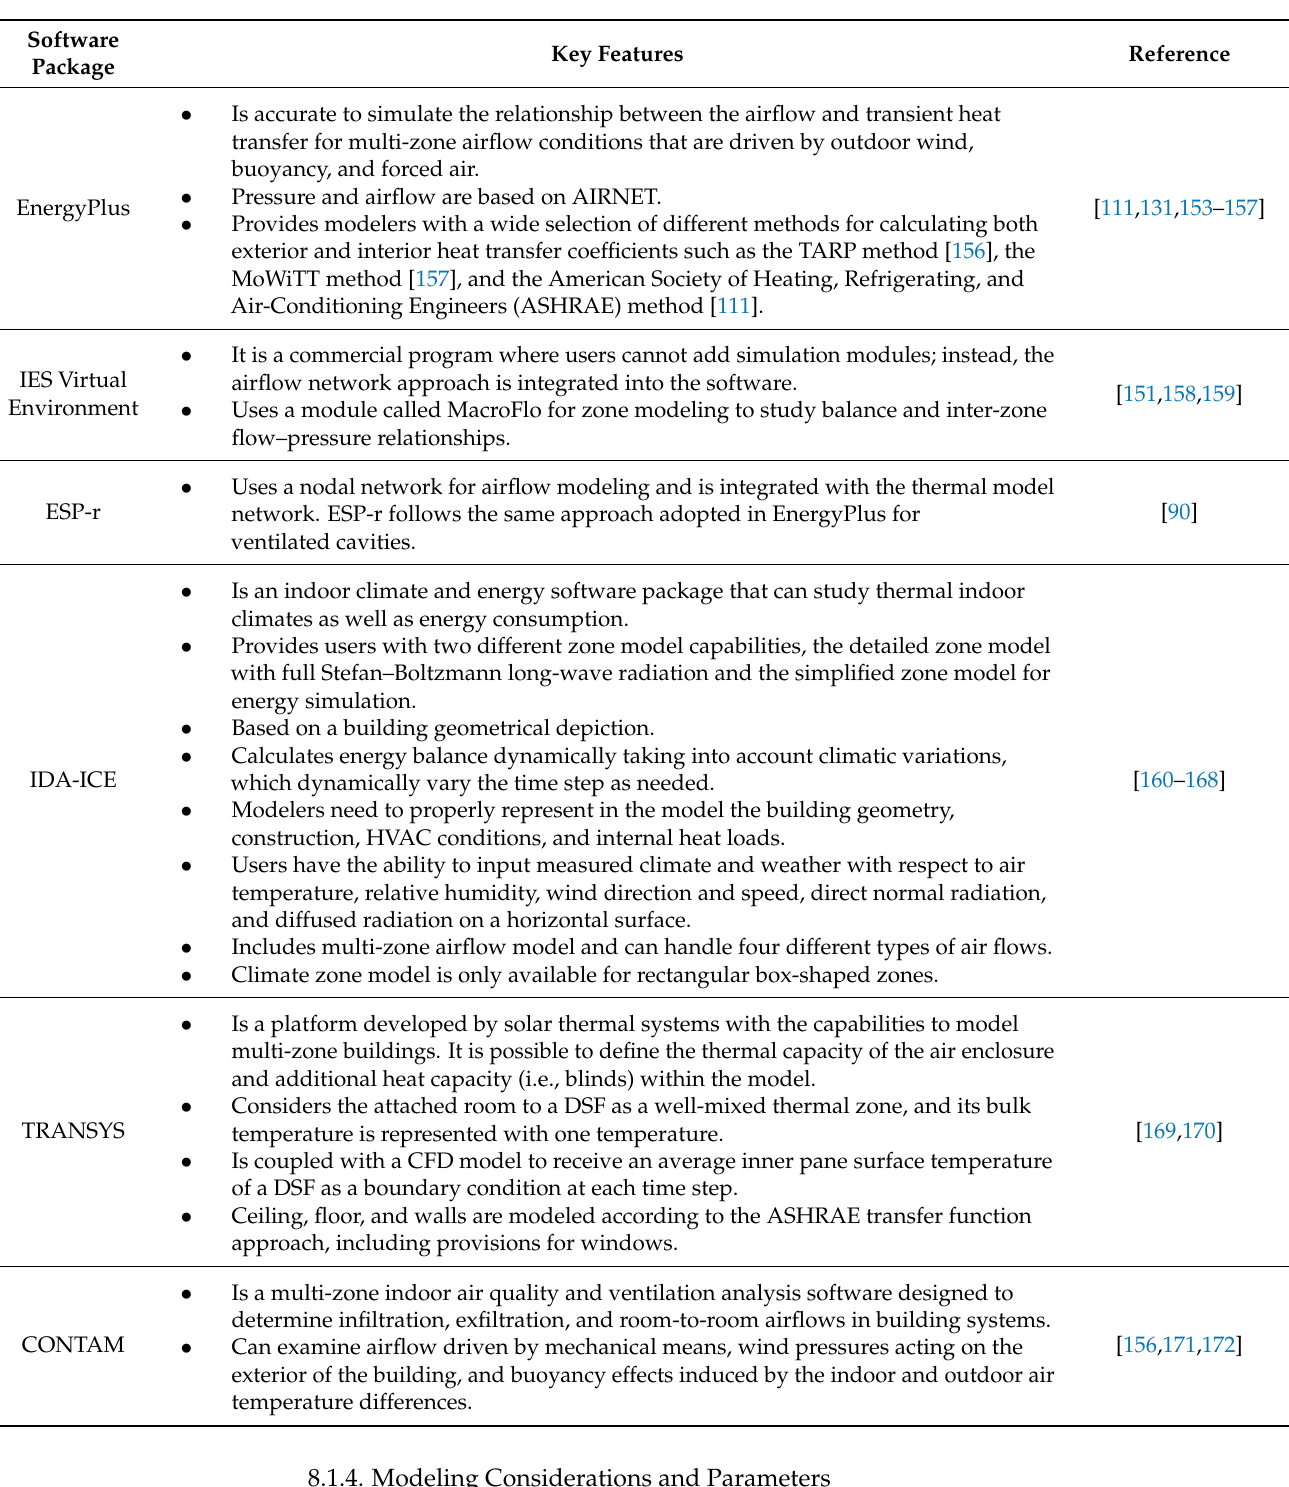
Table 11. Key Energy Modeling Software summary for package